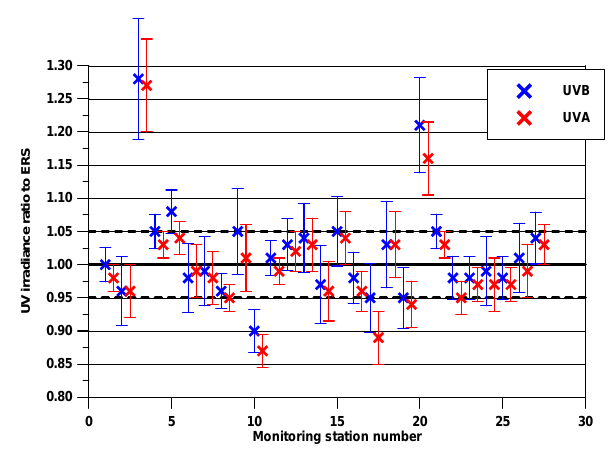
Figure 2. Mean differences and the 2 σ (standard deviation) of all 27 visiting instruments shown Fig. 2. Mean differences and the 2 σ (standard deviation) of all 27 as ratios of any instrument with the QASUME at UVB and UVA wavelengths. visiting instruments shown as ratios of any instrument with the QA- SUME at UVB and UVA